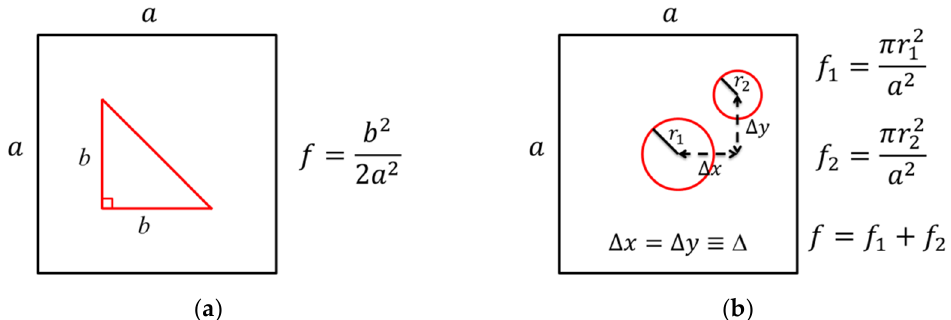
Figure 4. The investigated unit cells with ( a ) RIT and ( b ) CC shaped bases.